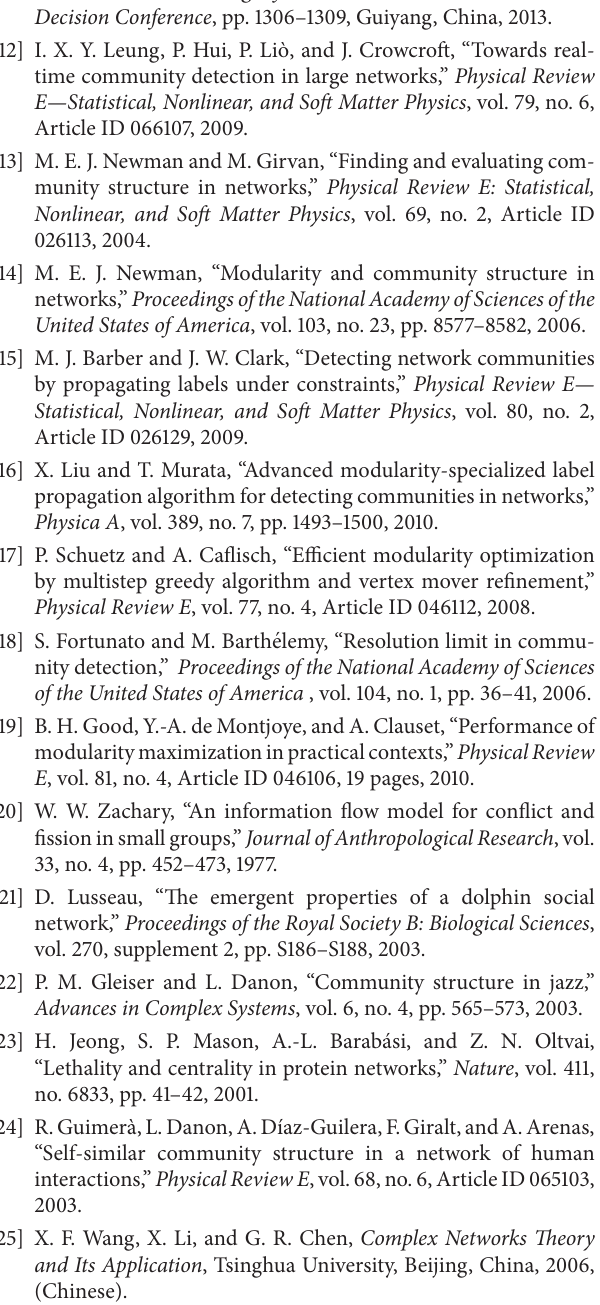
Table 7: Comparison between the results of network division by different algorithms on six real-world networks. GN Network